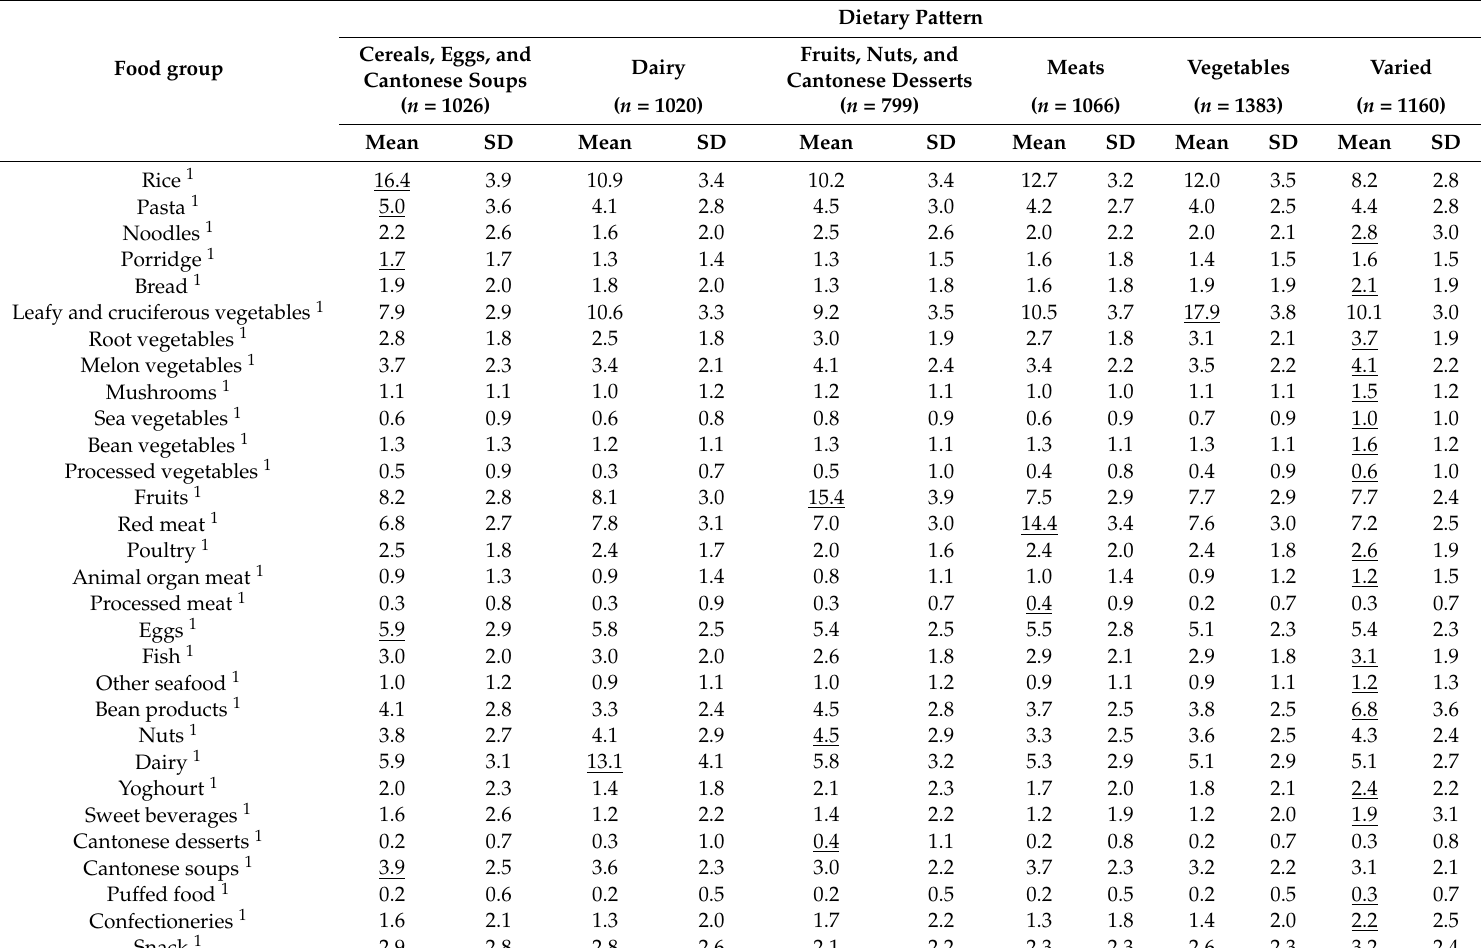
Dietary Pattern Fruits, Nuts,